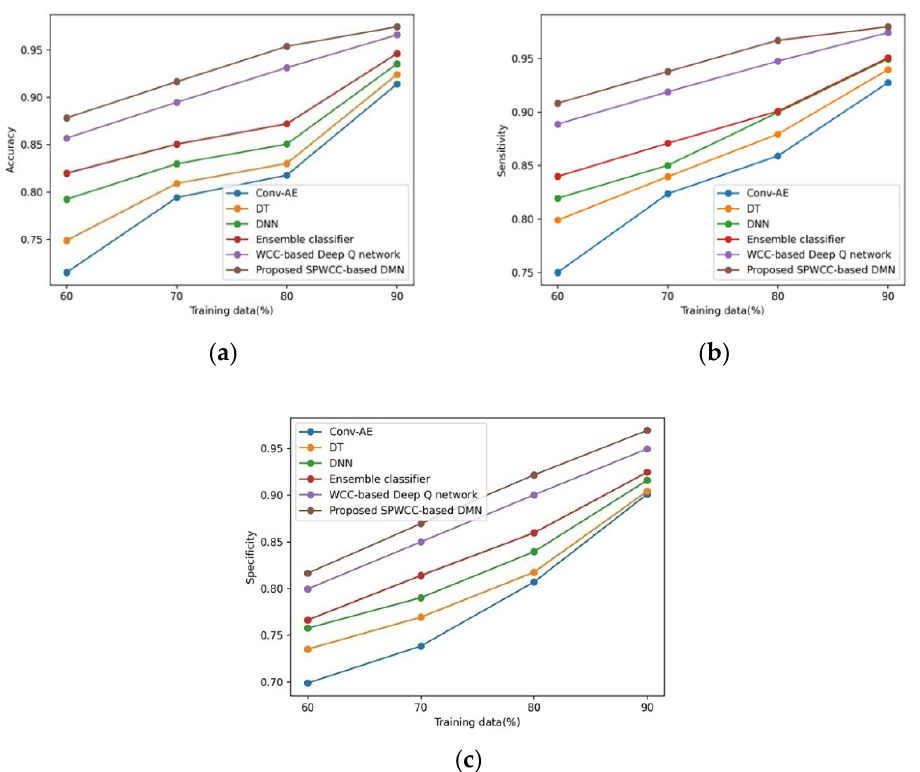
Figure 6. Assessment of techniques with probe attack considering ( a ) accuracy, ( b ) sensitivity, and ( c ) specificity.